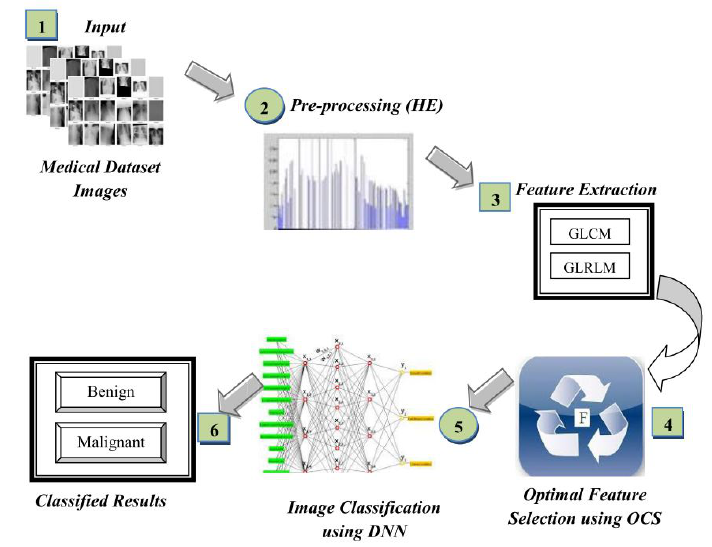
Figure 21. The presented classification DNN with the use of the OCS algorithm in [79]. S. S. Sarmah presented the IoT-centered deep learning modified neural network (DLMNN)